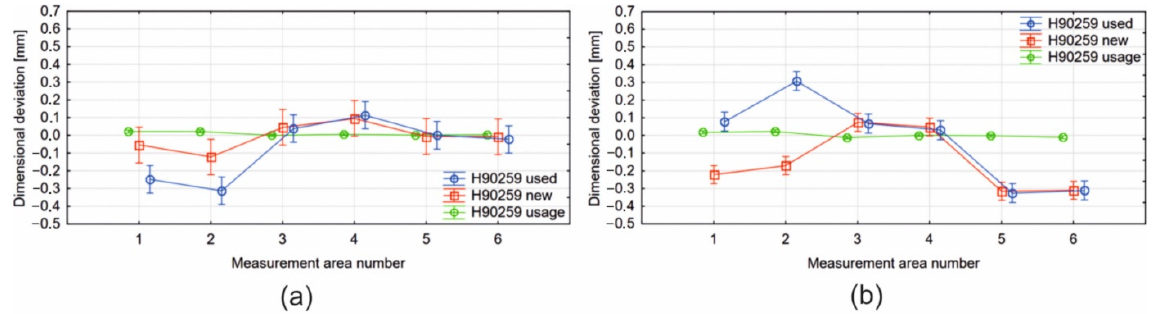
Figure 27. Results of ANOVA analysis for the porthole die 1: die core/bridge part ( a ) and die disc/insert ( b ).